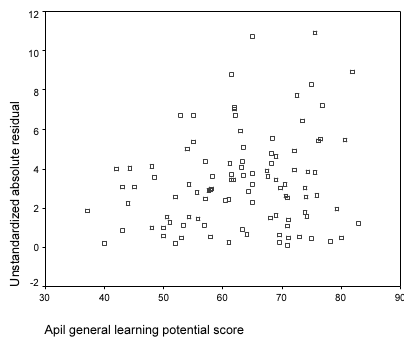
Figure 2: Absolute unstandardized residuals plotted against learning potential T ABLE 4 D ESCRIPTIVE STATISTICS FOR REAL AND